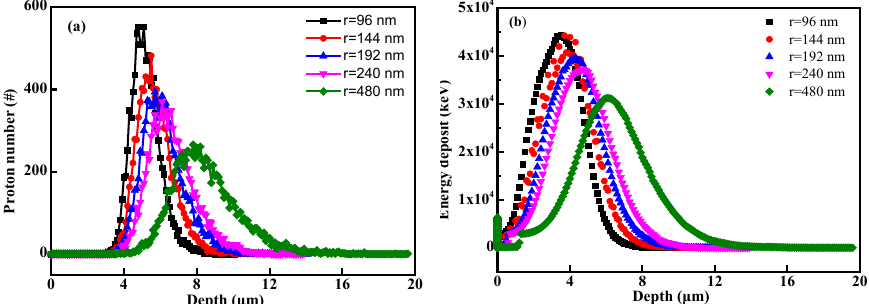
Figure 7. ( a ) The relationship between proton distribution and pore size (the porosity was set as 46.3%, and the radius was set as 96, 144, 192, 240 and 480 nm, respectively); ( b ) the relationship between energy deposition and pore size.